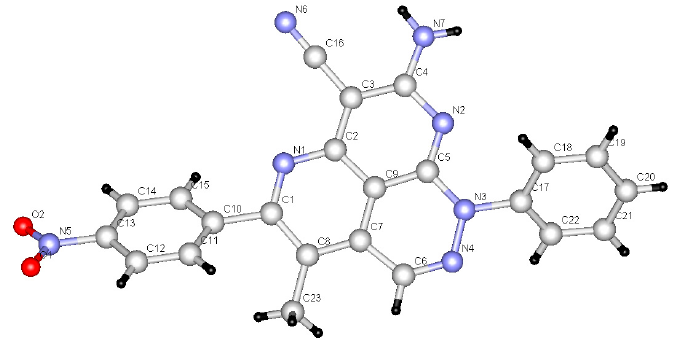
Figure 2. X-ray crystallographic structure of compound 12m [26].